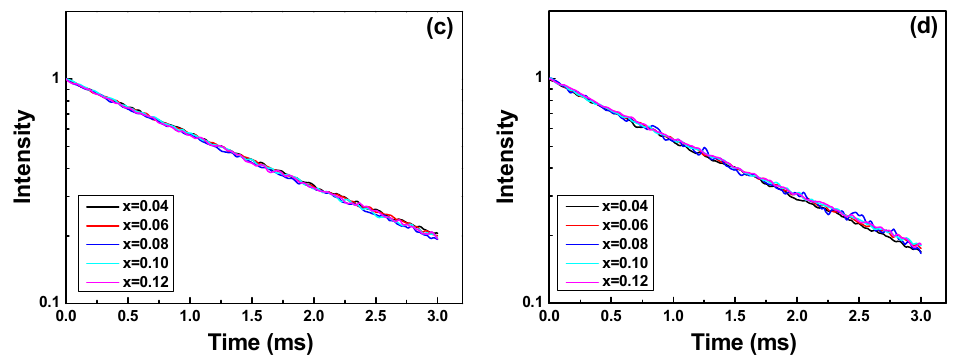
Figure 5. Luminescence lifetime of Sr 2 − x Eu x ZnMoO 6 phosphors synthesized at ( a ) 900 °C; ( b ) 1000 °C; ( c ) 1100 °C; and ( d ) 1200 °C, respectively.